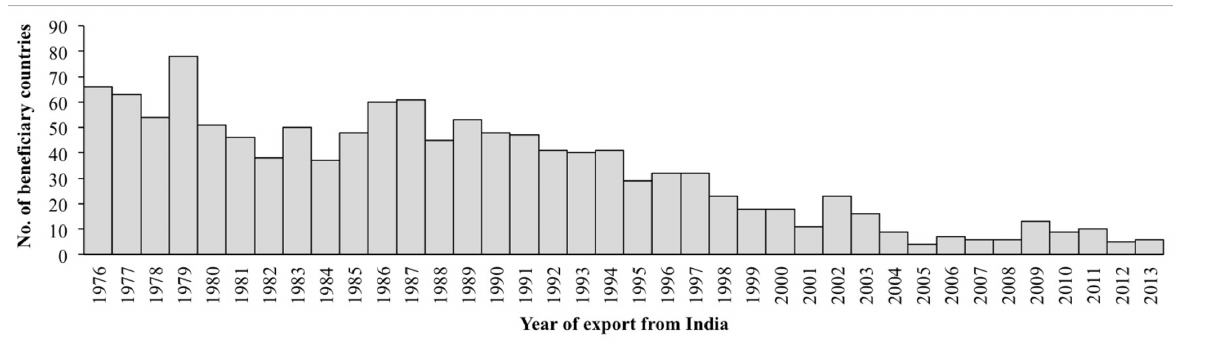
Fig 3. Year-wise profile of number of beneficiary countries that received germplasm from India.